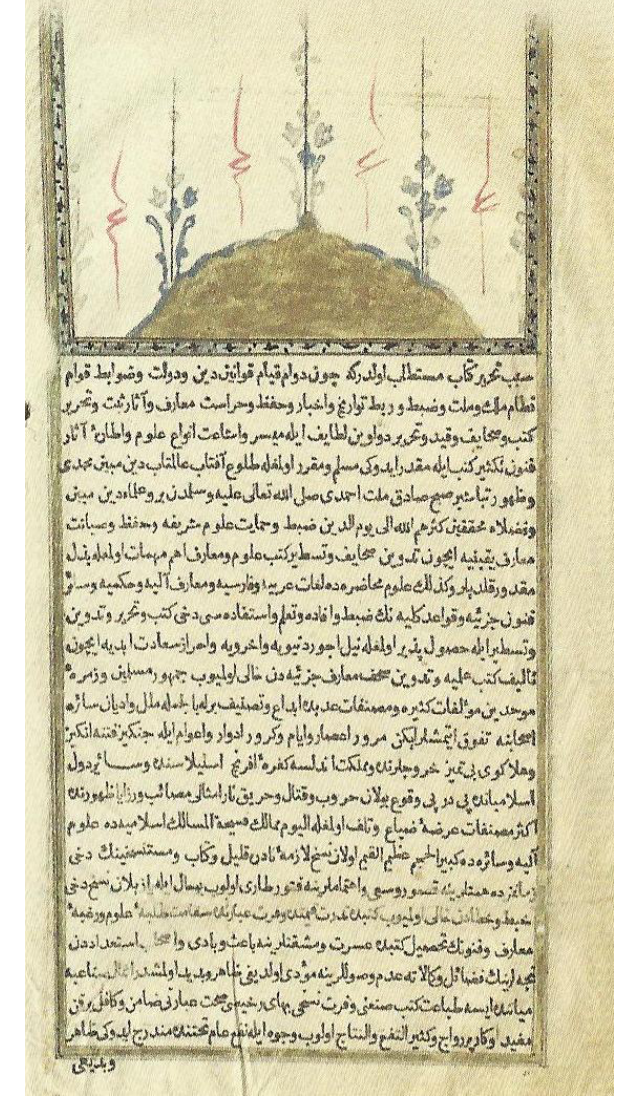
Figure 5. Cover page of The Report on the 1894 earthquake, pre- pared by D.